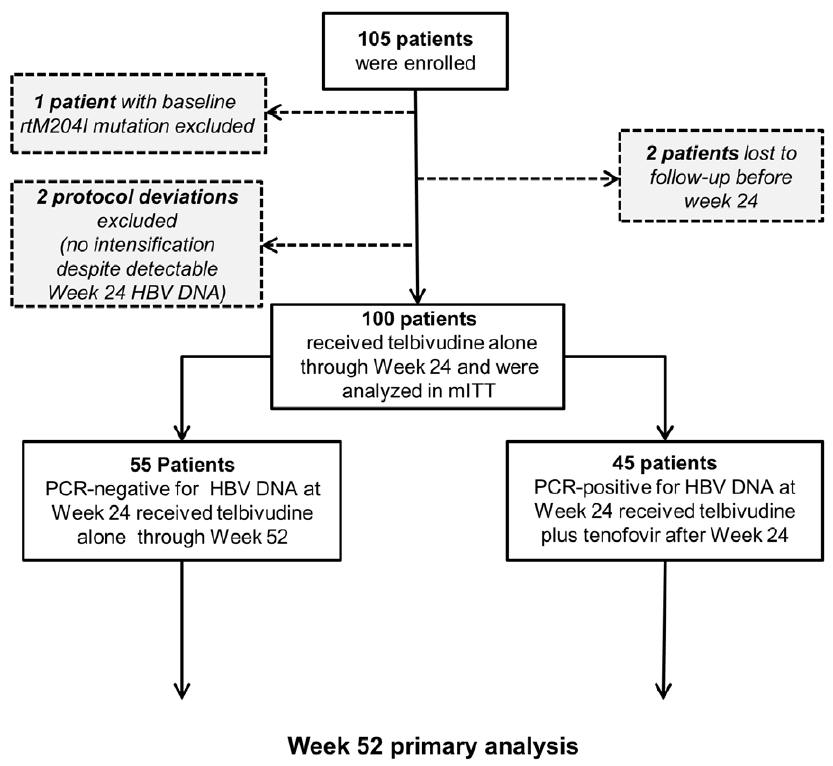
Figure 1. Patient disposition.